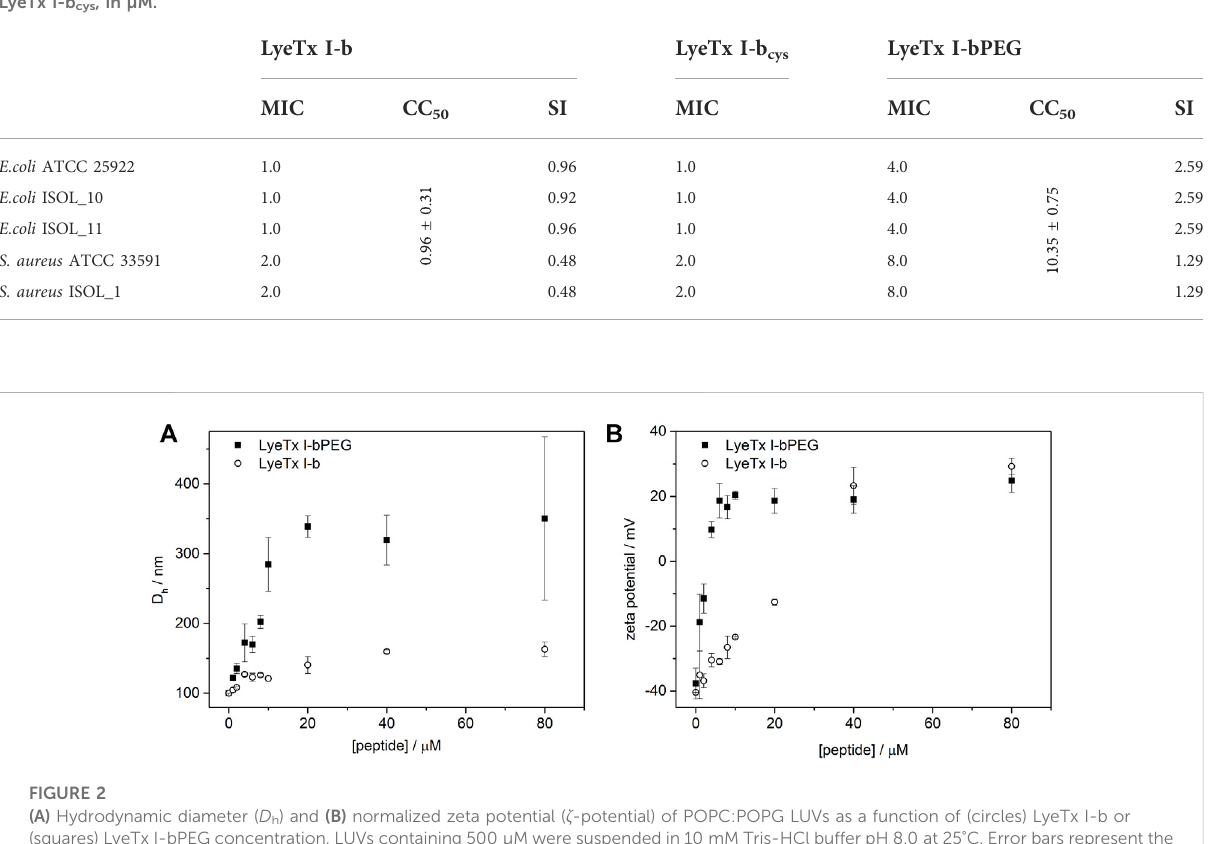
TABLE 1 Minimum inhibitory concentration (MIC), cytotoxic concentration (CC 50 ) and selectivity index (SI) of LyeTx I-b, LyeTx I-bPEG and MIC of LyeTx I-b cys , in µM.